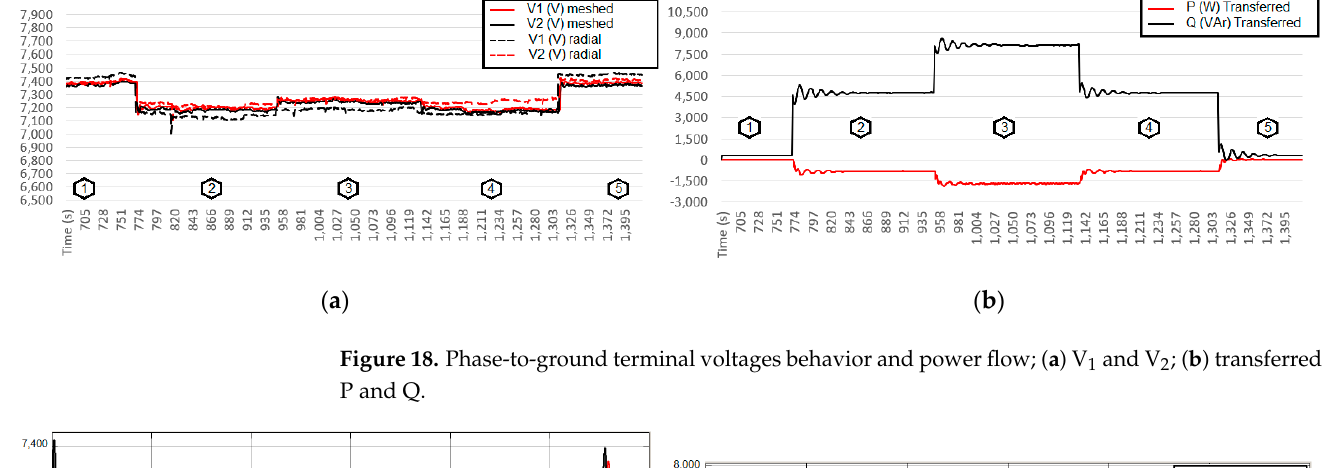
with the converter operation; ( a ) V 1 and V 2 ; ( b ) transferred P and Q.